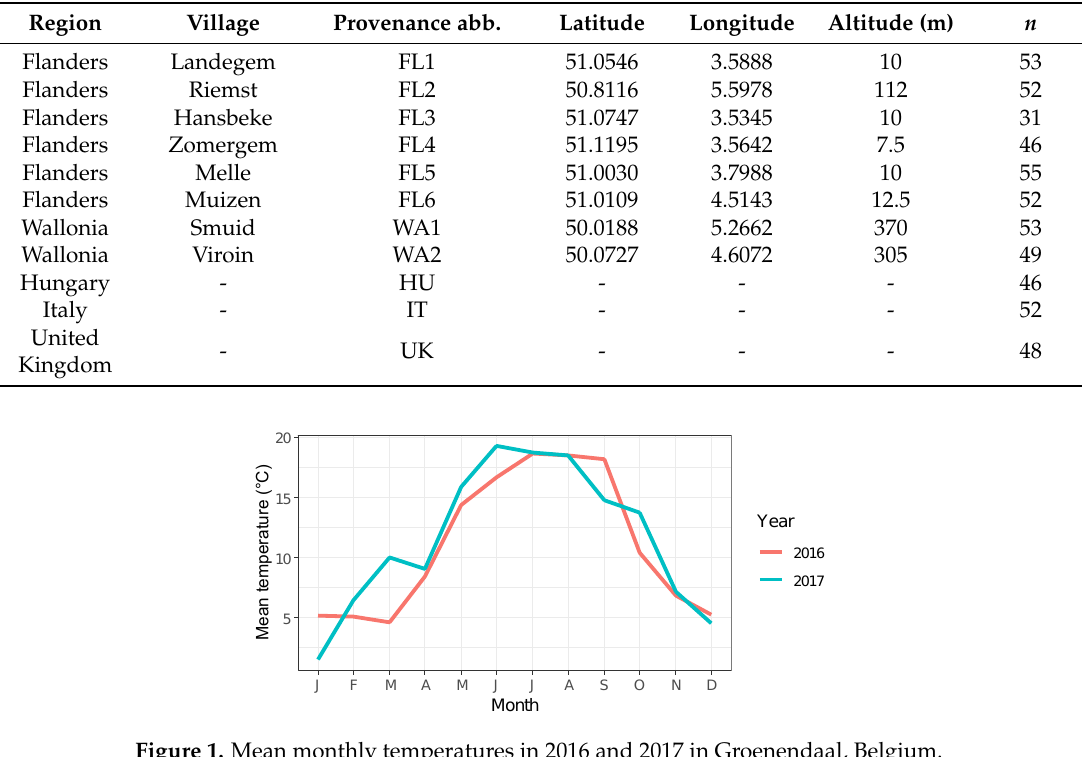
Table 1. Descriptive data of the provenances of C. monogyna in the common garden. No precise data on seed-stock populations were available for the commercial provenances. -: no data available. Region